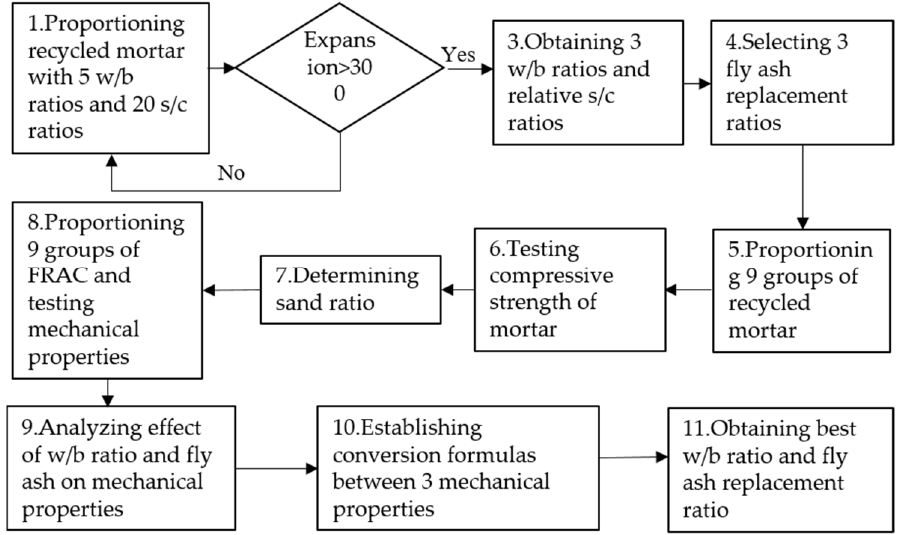
Figure 1. Research steps.